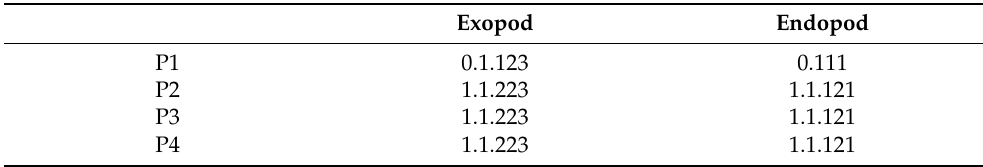
Table 2. Armature formulae of legs